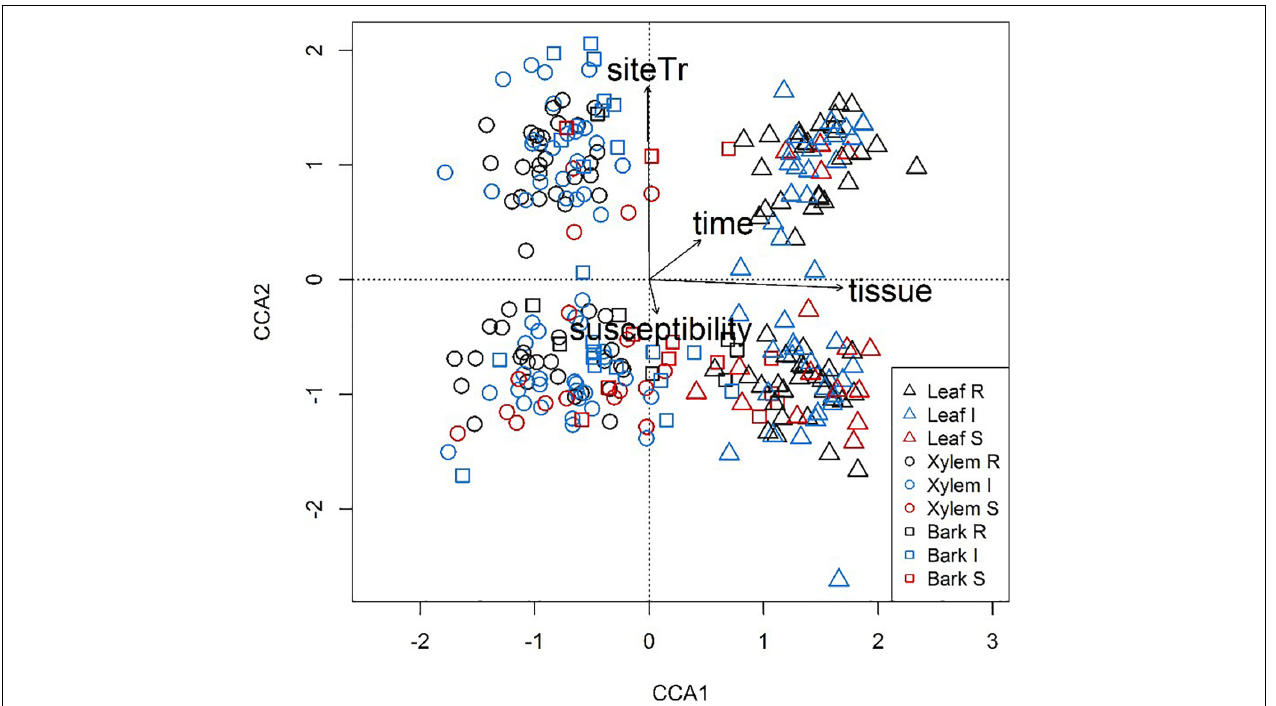
FIGURE 6 | Variation in fungal community composition visualized by canonical correspondence analysis (CCA) plot based on trophic levels assigned by FUNGuild for all ash samples. Samples are shape- and color-coded according to tissue type (leaves, triangle; xylem, circle; bark, square) and susceptibility class (Resistant, black; Intermediate, blue; Susceptible,